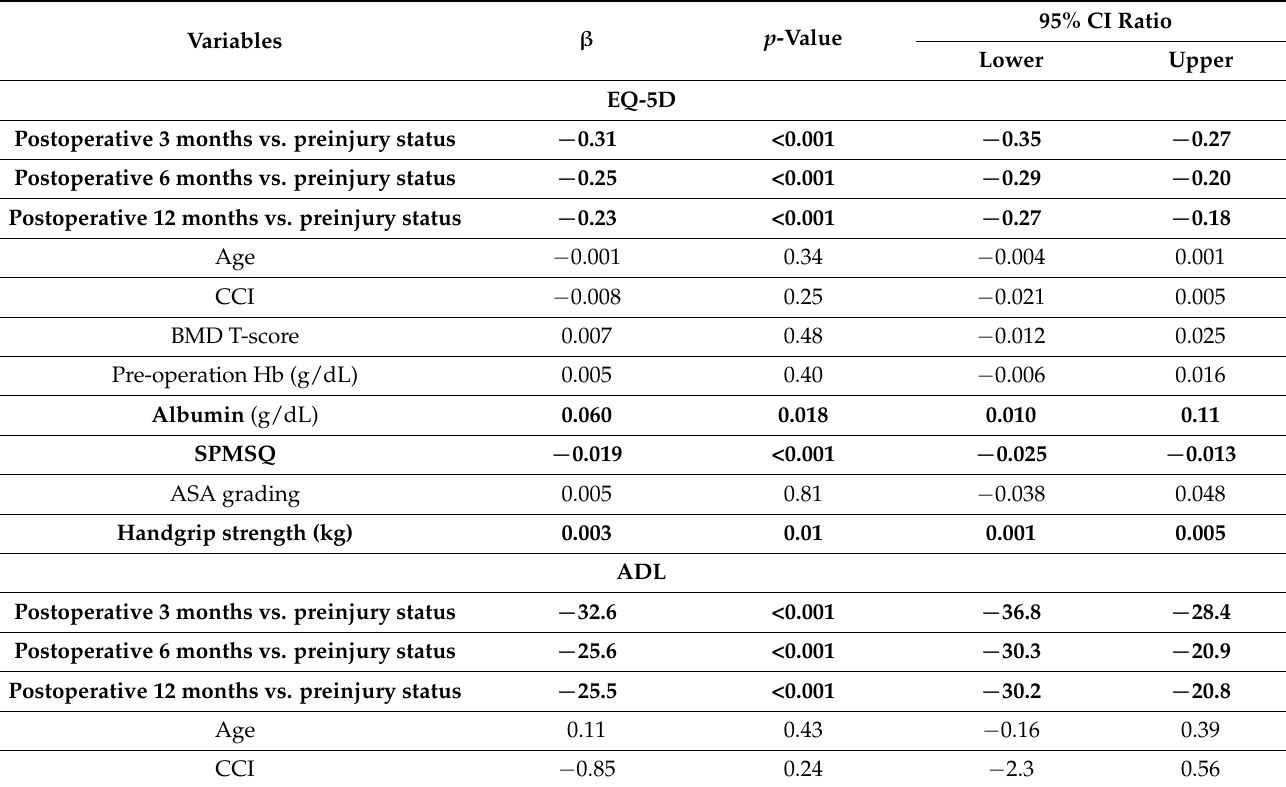
Figure 2. Consecutive ADL (BI) measurements at preinjury, 3, 6, and 12 months after hip fracture repair surgery. *: p < 0.001. Table 3. GEE model with multiple imputation of factors affecting postoperative EQ-5D and ADL in older adults with hip